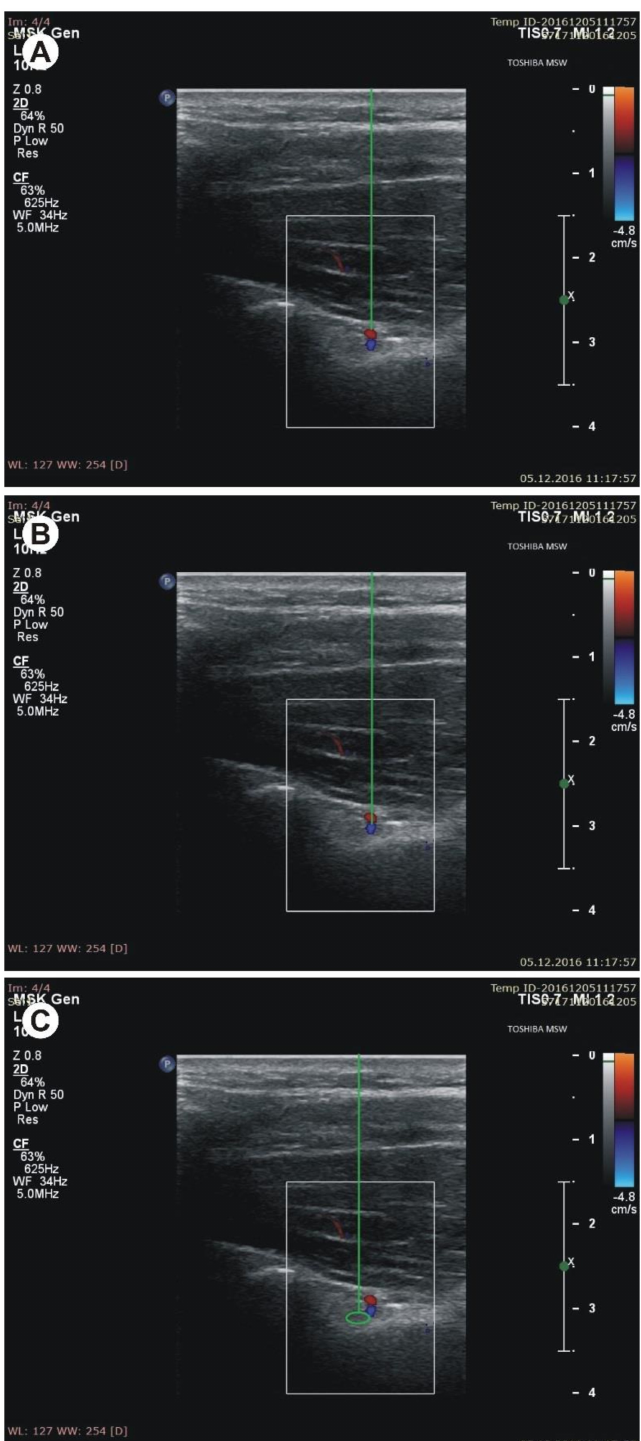
Figure 4. Measurements of the suprascapular notch region during ultrasonographic investigation. ( A ) the thickness of the soft tissue over the suprascapular artery; ( B ) the thickness of the soft tissue over the suprascapular vein; ( C ) the thickness of the soft tissue over the suprascapular